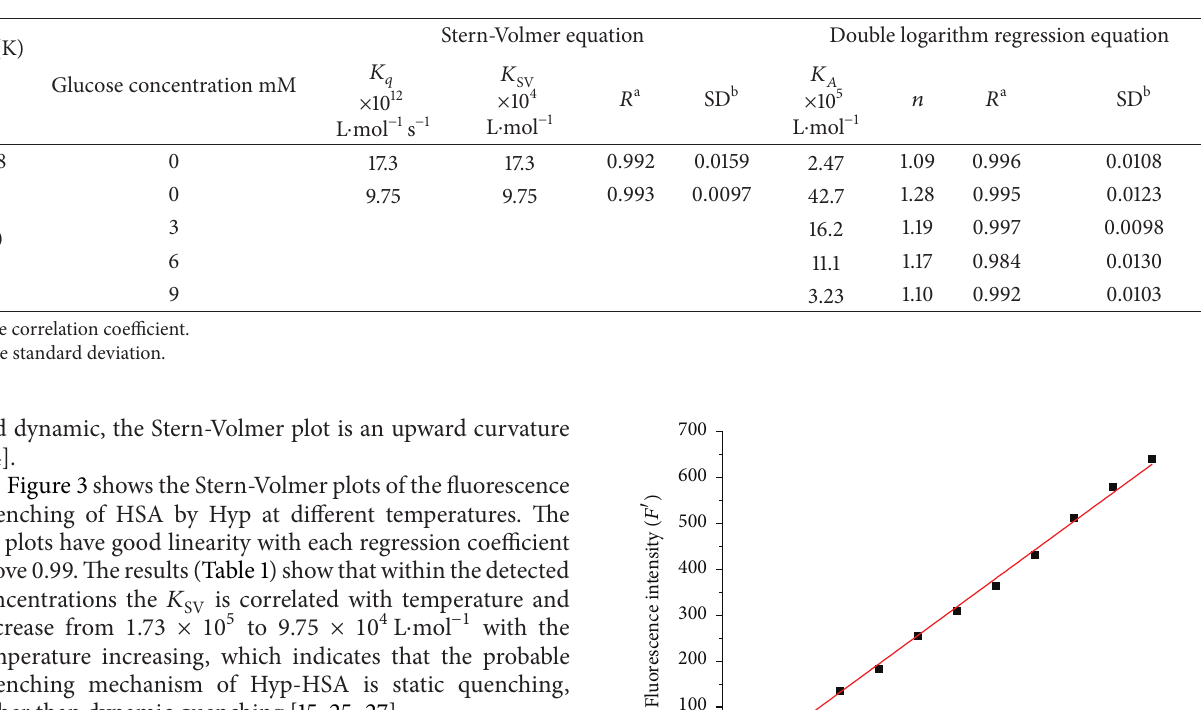
), binding constant ( 𝐾 𝐴 ), and the number of binding sites SV